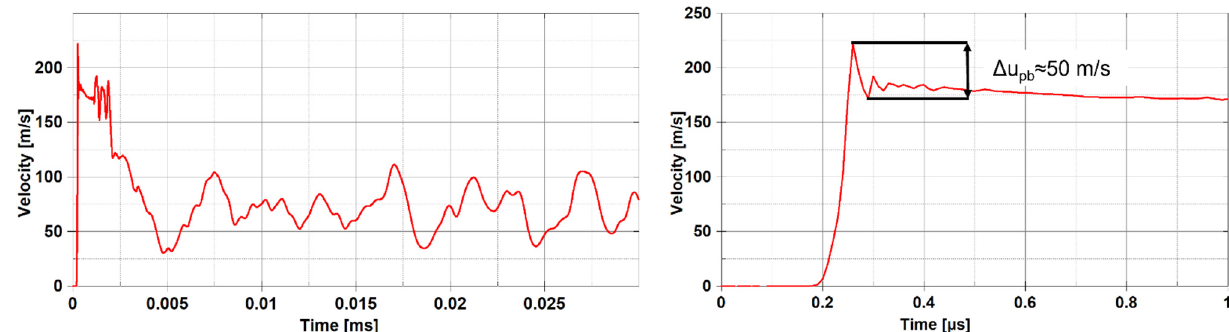
Figure 8. Axial velocity of the node at radius = 0 mm on the rear surface. The figure on the right is a portion of the left one.